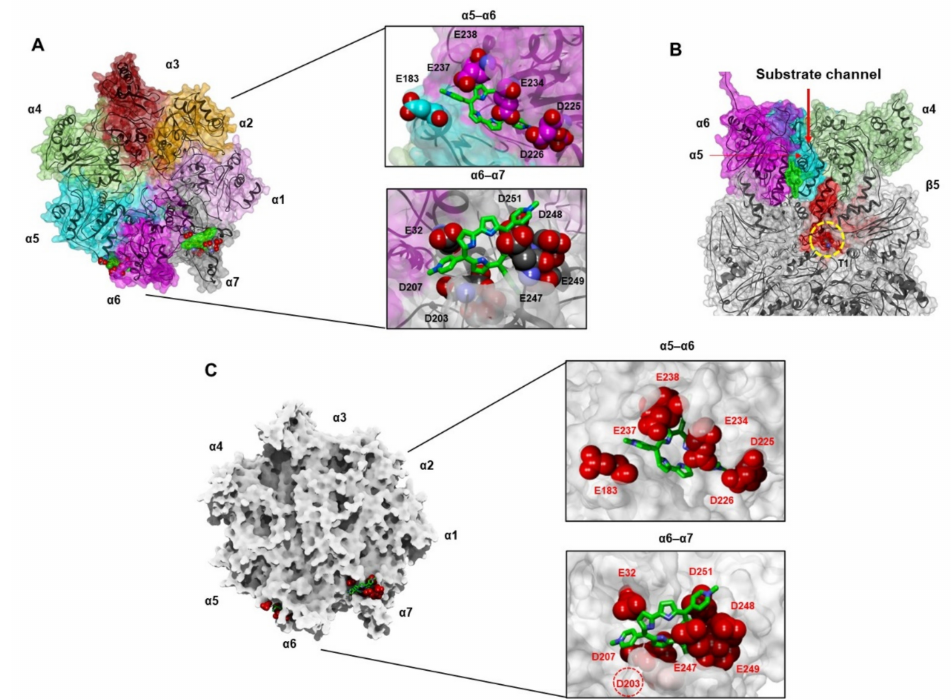
Figure 9. Selected docked complex of three TMPC molecules bound to human 20S (starting from the open conformation). ( A , C ): top and close-up view on the ligand binding sites at the α 5- α 6 and α 6- α 7 grooves. The negative residues interacting with TMPC and those in common with Tris-T4 are displayed in CPK. ( A ) h20S backbone is displayed as black solid ribbons, while the transparent solvent accessible surface (SAS) and the displayed residues are colored in pink ( α 1), orange ( α 2), brown ( α 3), light green ( α 4), cyan ( α 5), magenta ( α 6), and gray ( α 7). TMPC is colored by atom type (C: black; N: blue; O: red), and its SAS is displayed (green). ( C ) h20S SAS is displayed as solid and colored in white. TMPC is colored by atom type (C: green; N: blue; O: red) and displayed in stick. The h20S interacting residues are colored. The negative residues involved in ionic interactions with RPs are evidenced with a red dashed circle. ( B ) Transversal view and close-up view on the ligand binding site at α 5-loop. For clarity of presentation, just a cross section of h20S proteasome is shown. h20S backbone is displayed as black solid ribbons, while the surface is colored in green ( α 4), cyan ( α 5), magenta ( α 6), violet ( β 2), and red ( β 5). TMPC is colored by atom type (C: black; N: blue; O: red), and its SAS is displayed